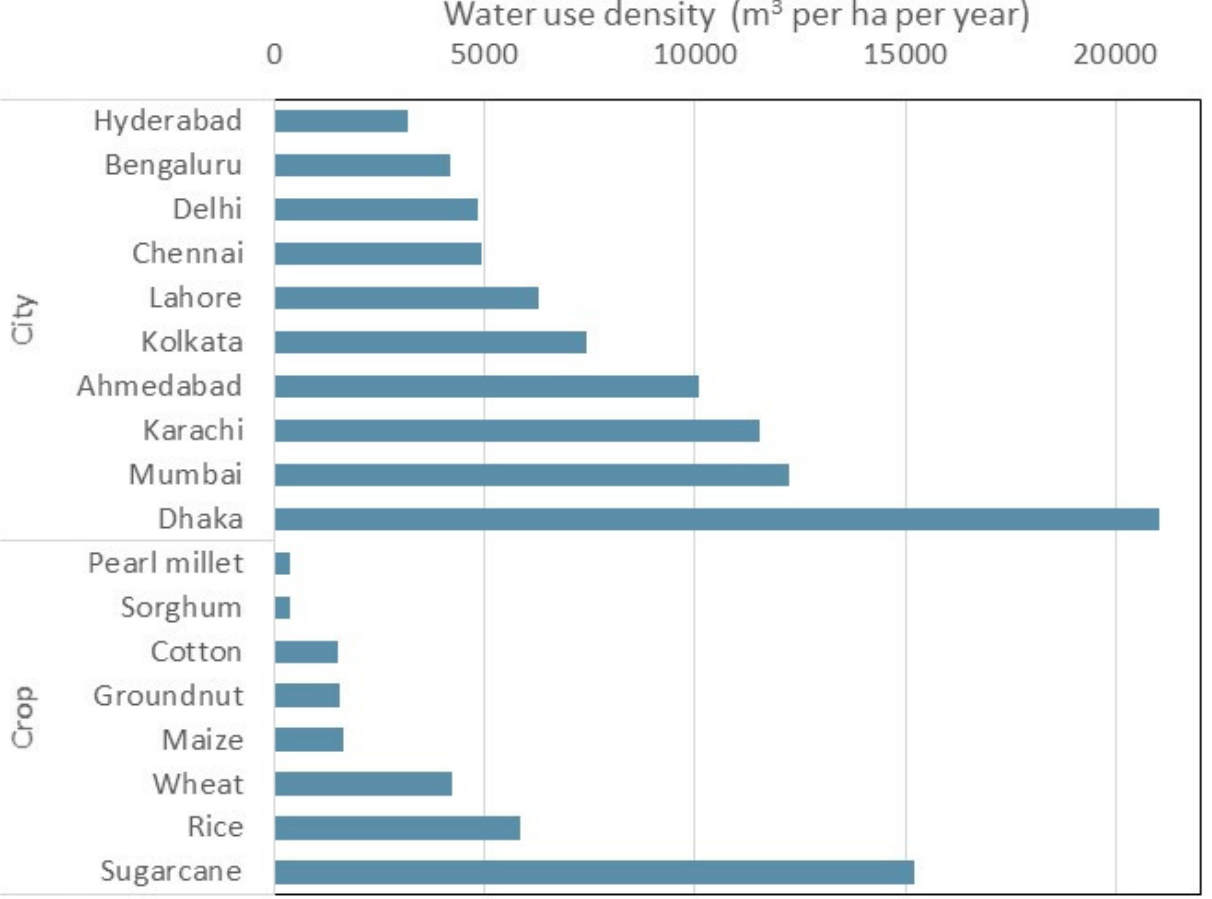
Figure 2. Cities tend to concentrate high water use in relatively small geographical areas, compared to agricultural areas.